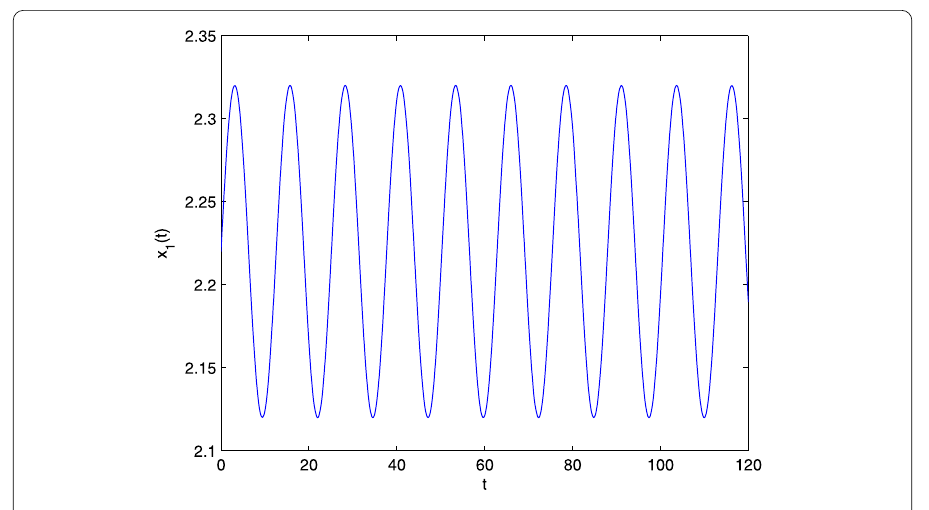
Figure 1 State trajectories of system (4.1) for x 1 ( t )